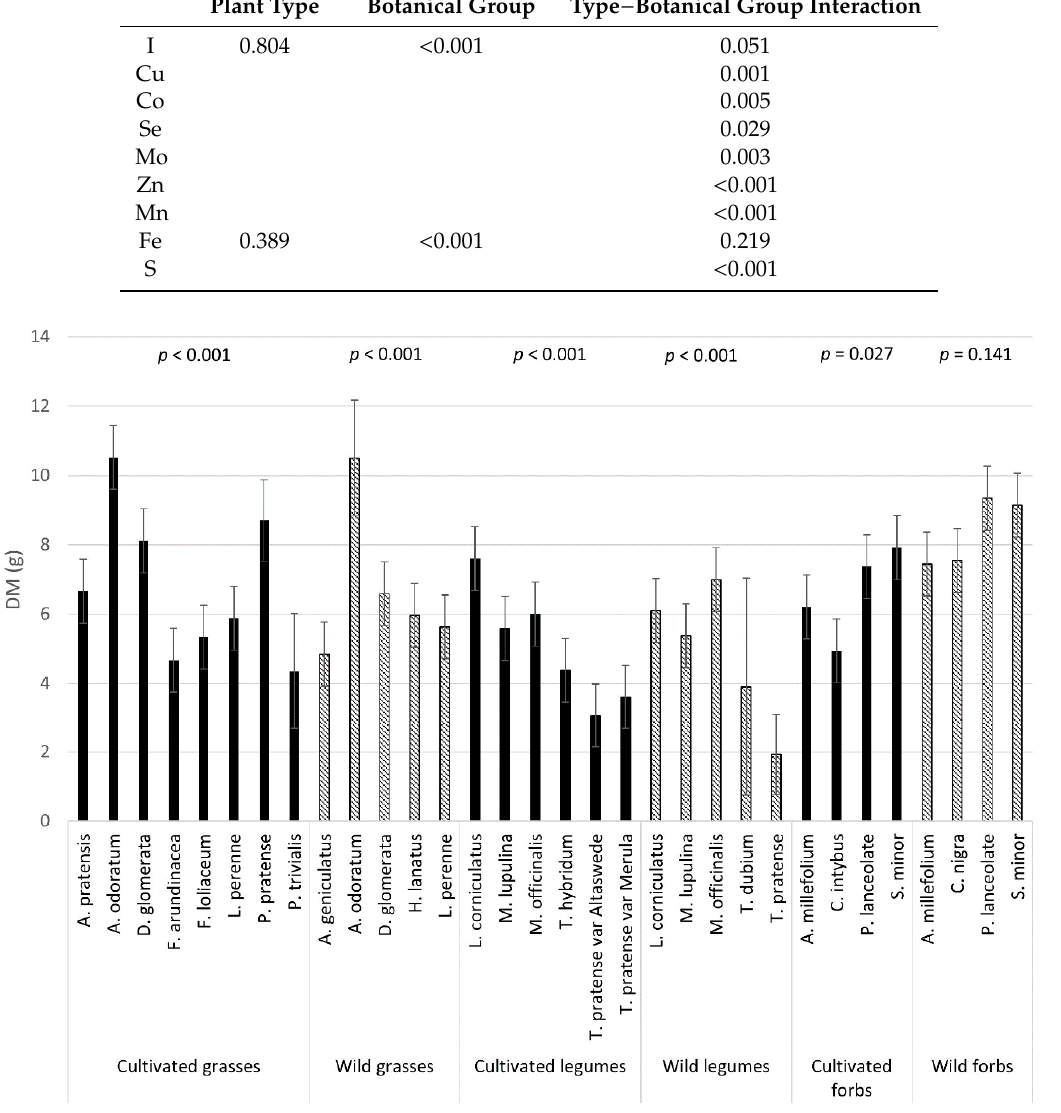
Table 2. Summary of linear mixed model (LMM) analysis showing whether there is a statistically significant interaction between plant type (wild / cultivated) and botanical group (forb / legume / grass) for the concentration of 9 minerals in plant biomass. Where the interaction is not significant ( p > 0.05), the significance of the individual e ff ects is reported.